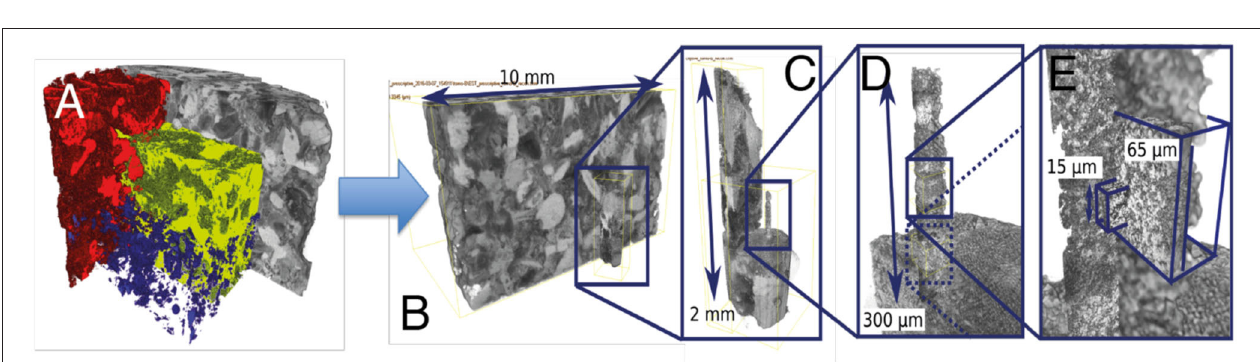
FIGURE 2 | A core of Estaillades is scanned in the µ CT (A) and the pores (red), solid grains (blue), and microporous grains (yellow) are identified. A subsection is identified (B) and milled (C) . A section of the milled section (D) is then scanned in the nano-XRM (E) .